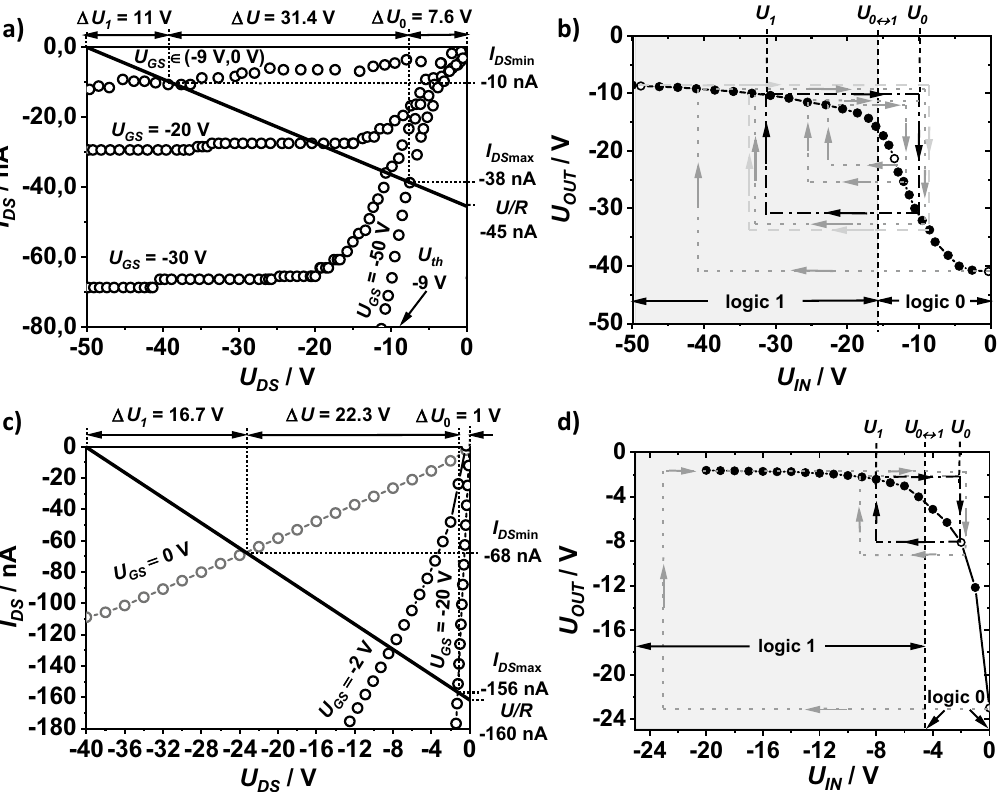
Figure 7. Load line for the fully-printed inverter INV1 with a transistor with a layer of DPPDTT and a resistor with a layer of P3HT, molecular weight 30 kDa, area 2 mm 2 , supplied by − 50 V ( a ); and for INV2 where the drain current was enhanced in relation to INV1 by increasing the channel width of the transistor and the dimensions of the P3HT resistor to 6 mm 2 ( c ). Transfer characteristics of INV1 ( b ) and INV2 ( d ). Gray dashed lines with arrows indicate the directions of changes in the input and output voltages of successive inverters. The light gray lines and arrows show the voltage evolution after applying the smallest voltage in the circuit (logical 1) to the input of the first inverter. The dark gray lines and arrows show the voltage evolution after applying a voltage higher than the threshold voltage U 0 ↔ 1 (logical zero). The black dashed-dotted lines and black arrows show a closed cycle of voltages on the inputs and outputs of three (or more) inverters connected in series ( b , d